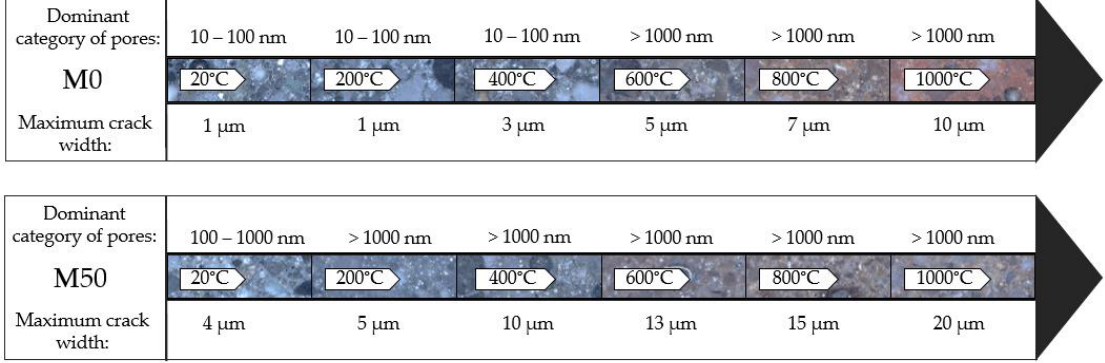
Figure 14. Diagram showing the most important changes in the microstructure of materials made solely based on FA and with the addition of GGBFS.